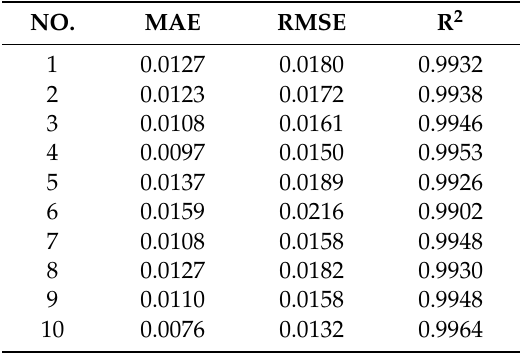
Table 5. Performance index data of extreme learning machine (ELM) sub–models (Validation set).